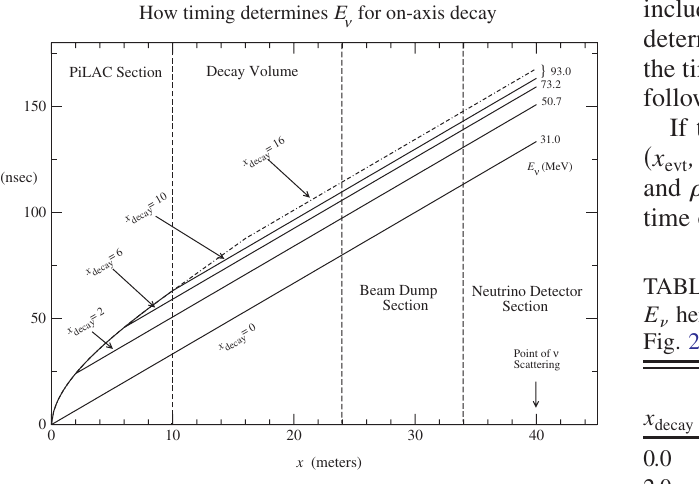
FIG. 3. Relation between decay time after pion bunch injection and time of scattering event in detector for on-axis (cid:1) ’s of the highest energy. This is for an unrealistic injection energy of ¼ 100 keV , so that the curvatures before decay are highly T (cid:3) exaggerated.